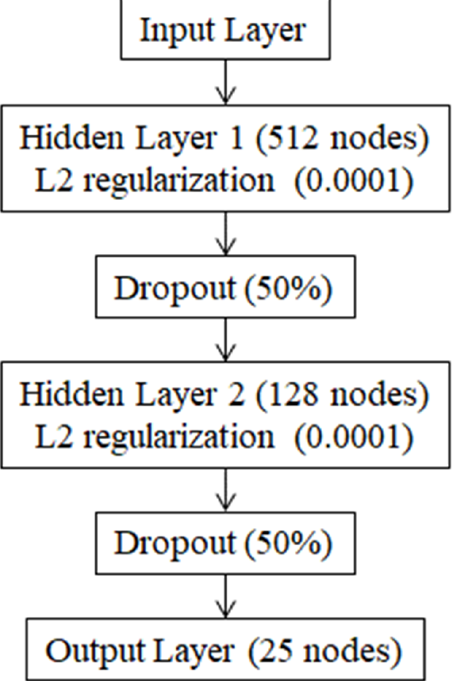
Figure 2. MLP classifier used for the single-band and spectral fusion studies.